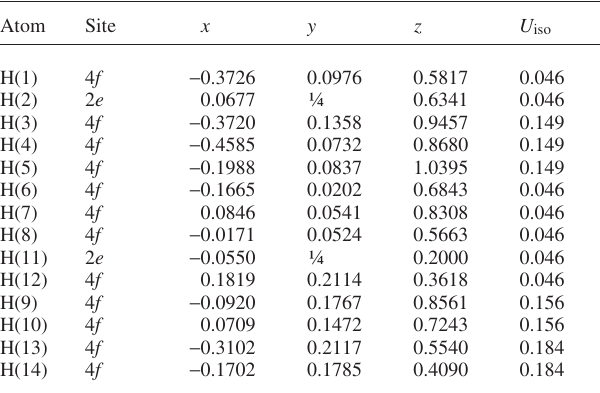
Table 2. Atomic coordinates and displacement parameters (in Å 2 ) . Table 1. Data collection and